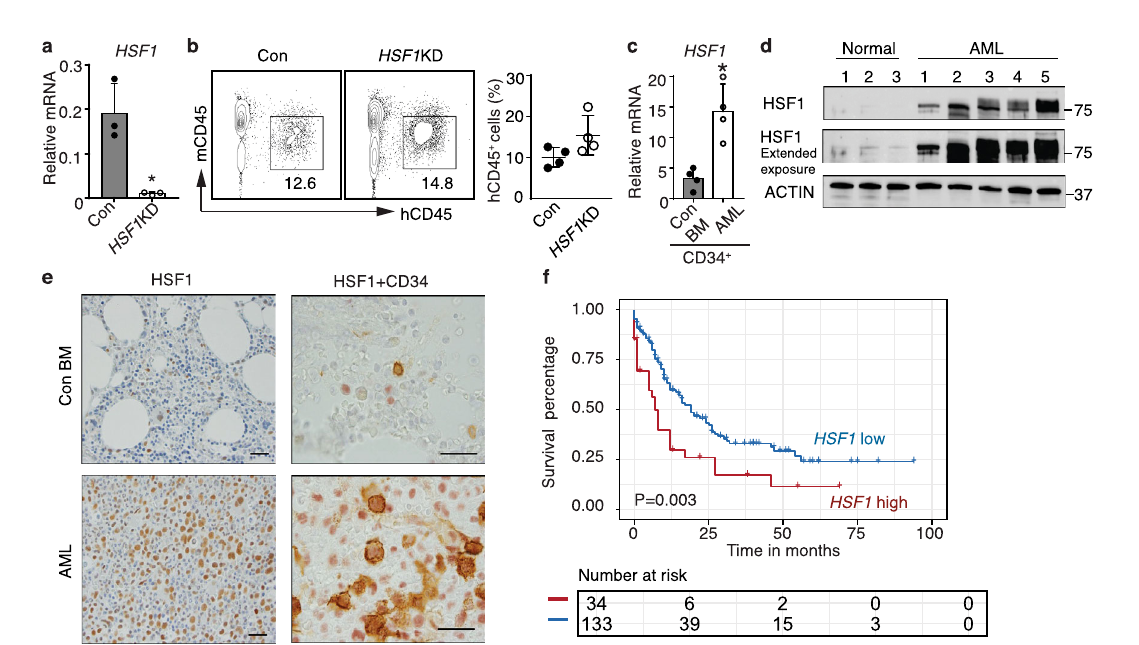
Fig. 5 | HSF1 is a key regulator of oxidative phosphorylation in AML. For experiments ( a – m ), Hsf1 fl / fl creER mouse MLL-AF9 LSPCs were treated with or without (Con) 200nM 4-OHT for different times. a 2-NBDG uptake ( n =3 inde- pendent replicates). b Mitochondrial membrane potential (Mitotracker, n =3 independent replicates). c Mitochondrial superoxide (Mitosox, n =4 independent replicates), * p =0.0017. d , e Mitochondrial ROS levels measured by H2-DCFDA ( d , n =4 independent replicates, * p =0.0106) or CellROX ( e , n =3 independent replicates, * p =0.0016). f , g OCR ( f , * p =5.9 × 10 − 18 , ** p =4.3 × 10 − 11 ) and ECAR ( g , * p =5.3 × 10 − 7 , ** p =8.8 × 10 − 8 ) measured by Seahorse ( n =8, independent replicates each). h ATP production ( n =3 independent replicates). * p =3.57 × 10 − 5 , ** p =0.000795. i Leukemia cell intermediate metabolites (n=5 independent replicates) using high-resolution Gaschromatograph mass spectrometry (GC/MS). j 13 C6-Glucose tracing (measuring leukemia cell intermediate metabolites) using GC/MS. Left, illustration of glucose metabolism. White circles, 12 C carbons; blue circles, 13 Ccarbons.M+2and M+3refertothe numberof 13 C carbons.;Right, TCA intermediates: citrate (* p =0.00167), succinate (* p =0.0121), fumarate, and malate (* p =0.0011) and intracellular metabolites: pyruvate, alanine, lactate (* p =0.0146), glutamate (* p =0.00014), and aspartate (* p =0.00098). Data are the isotopologue distribution relativeto abundance and normalized to the controlgroup, plottedas